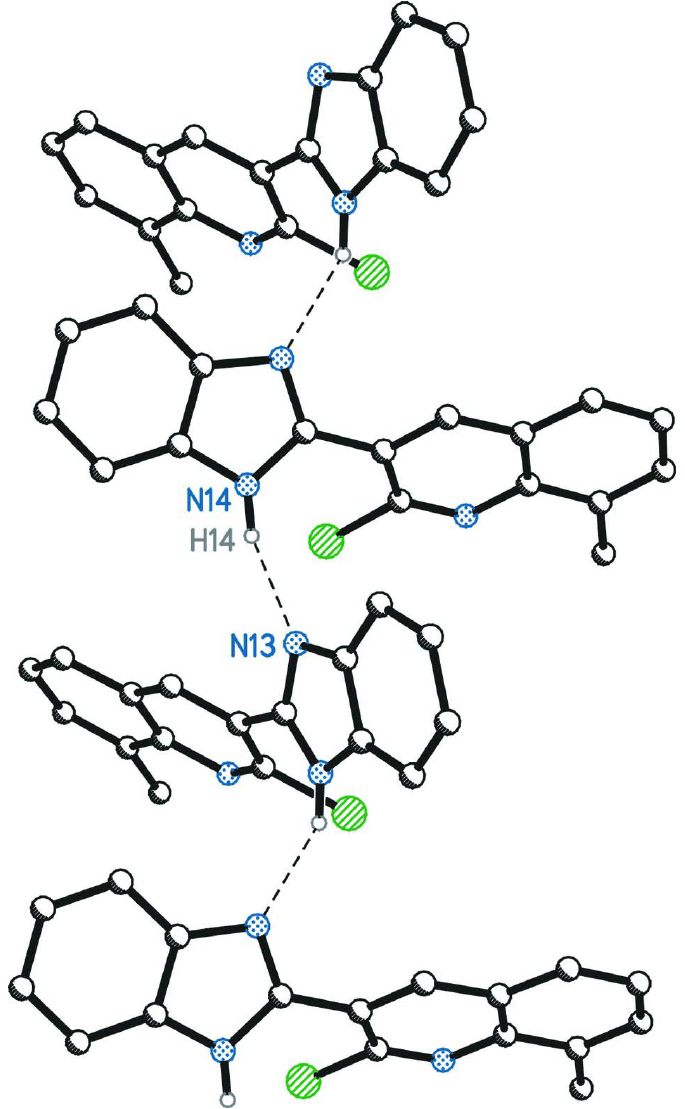
Figure 2 Ball and stick representation of the hydrogen bond connected chain along the c direction. Hydrogen atoms not involved in hydrogen bonds (dashed lines) have been omitted. Each of the two independent molecules forms such an assembly, the analogous chain of the second molecule is not